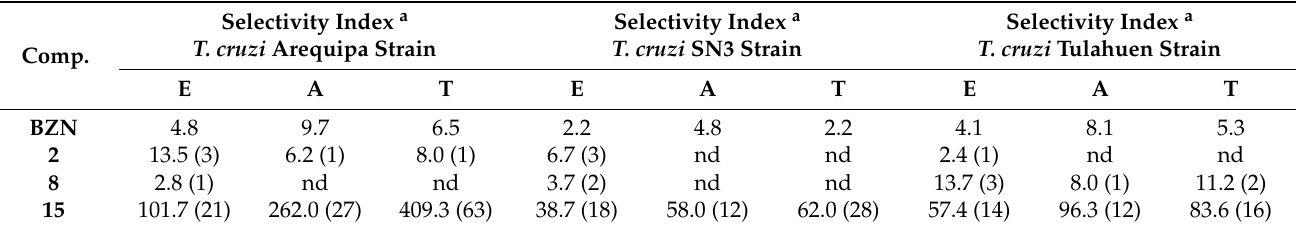
Table 2. Selectivity index for benznidazole and selected compounds against the three developmental forms of Trypanosoma cruzi